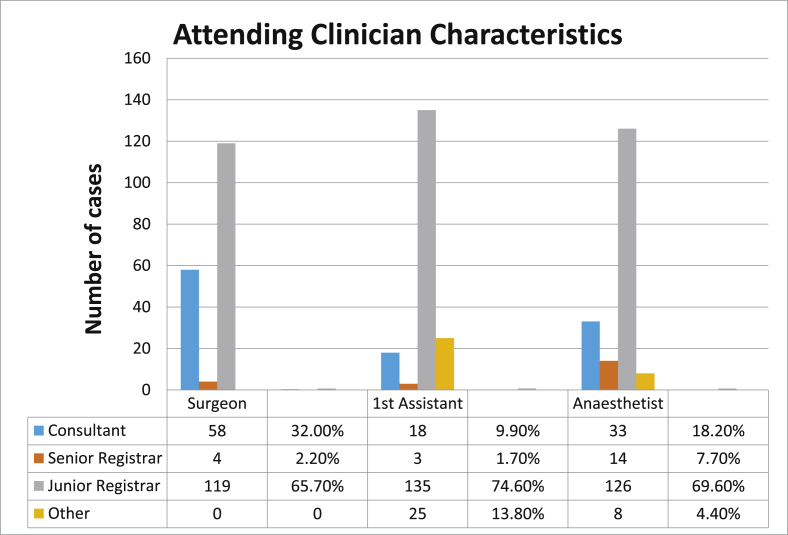
Attending clinician's characteristics.